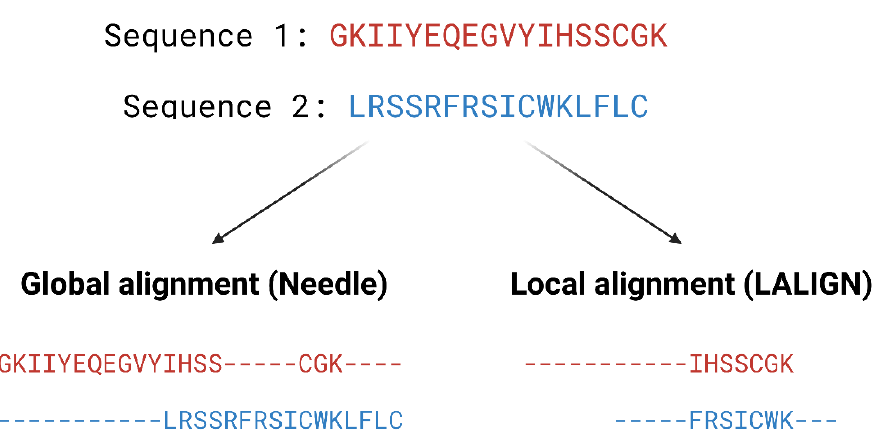
Figure 4. Example of global and local alignment using Needle [32] and LALIGN [32]. Global alignment aims to find the best alignment across the two entire length of sequences. Local alignment finds regions of high similarity in parts of the sequences.